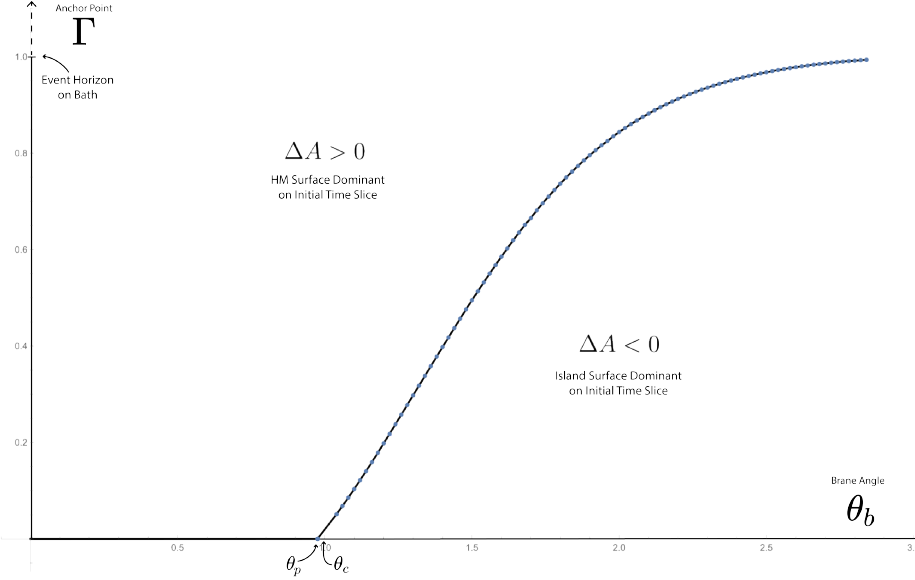
Figure 11 . The phase diagram depends on the anchor point Γ and the brane angle θ b . When the brane lies above the Page angle, the island surfaces are dominant when Γ is sufficiently small; as the brane angle increases the island surfaces are dominant for increasingly large values of Γ . For anchor points outside the boundary black hole’s horizon ( Γ < 1 ), the island surfaces become dominant as we take θ b → π